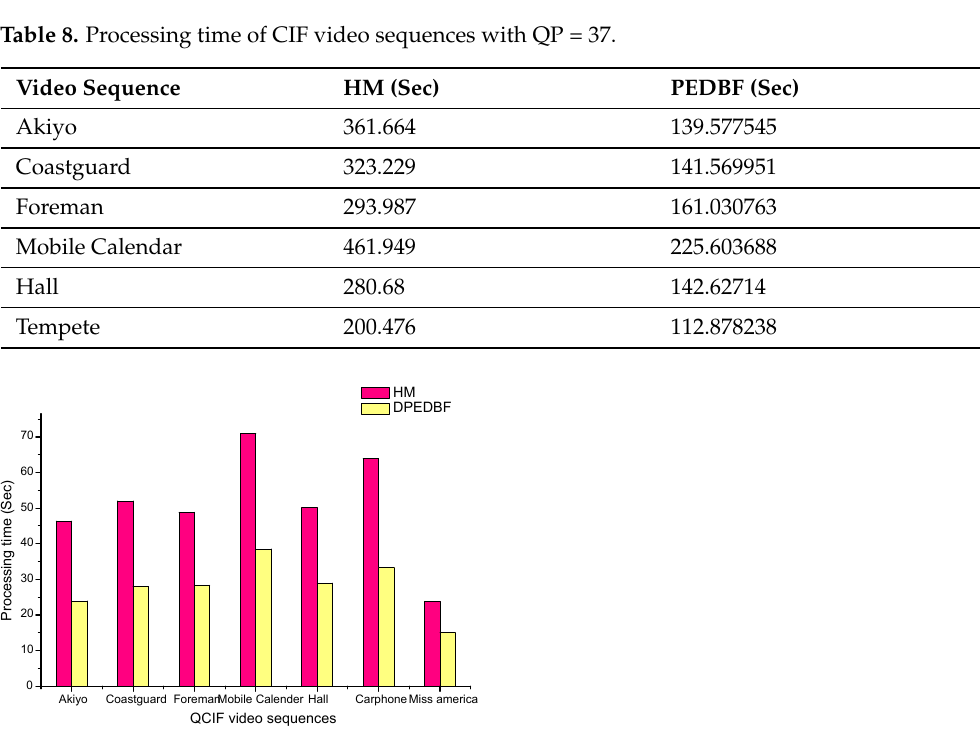
Figure 23. Comparison of processing time with HM for QCIF video sequences using QP = 37.